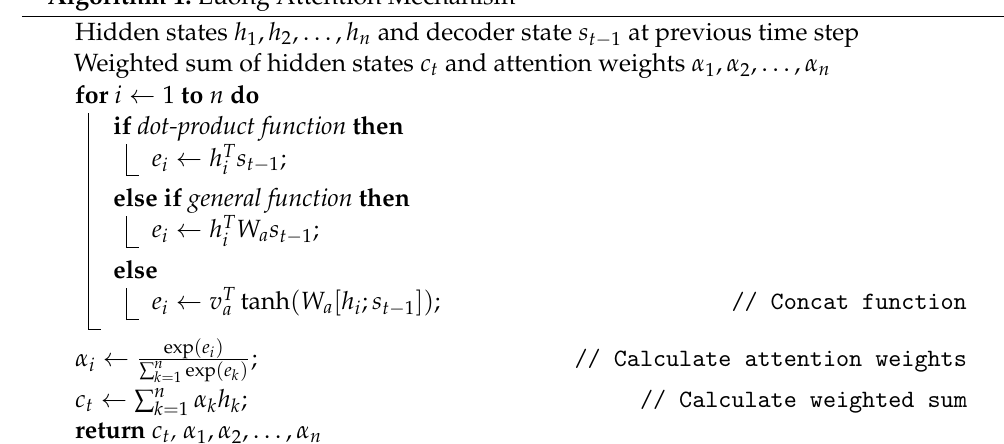
Algorithm 1: Luong Attention